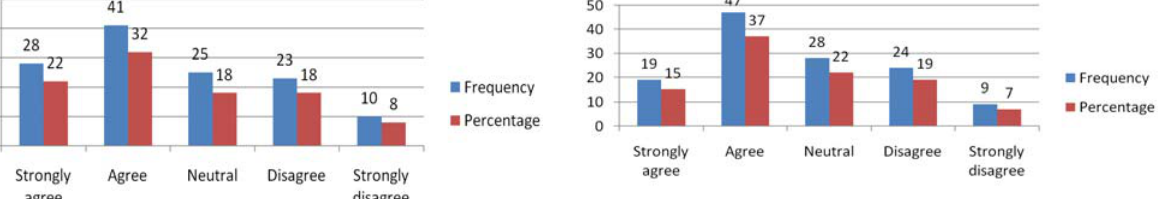
Fig. 5. Environmental regulation requirements as challenges for business